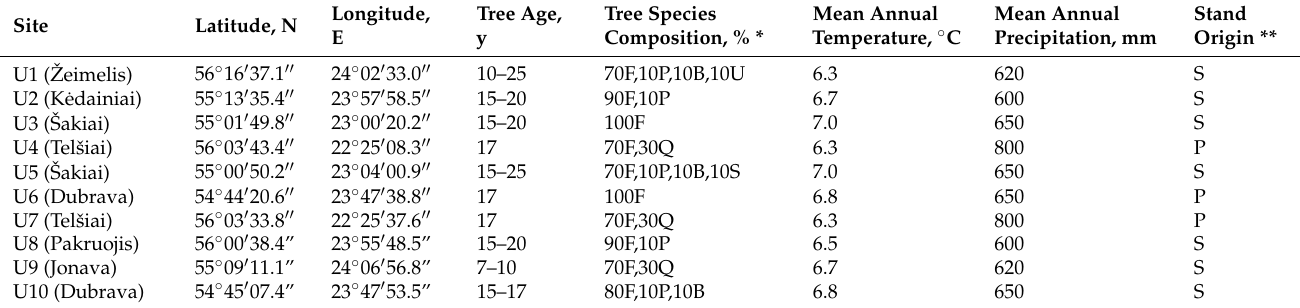
Table 1. Fraxinus excelsior sites in Lithuania investigated in the present study.